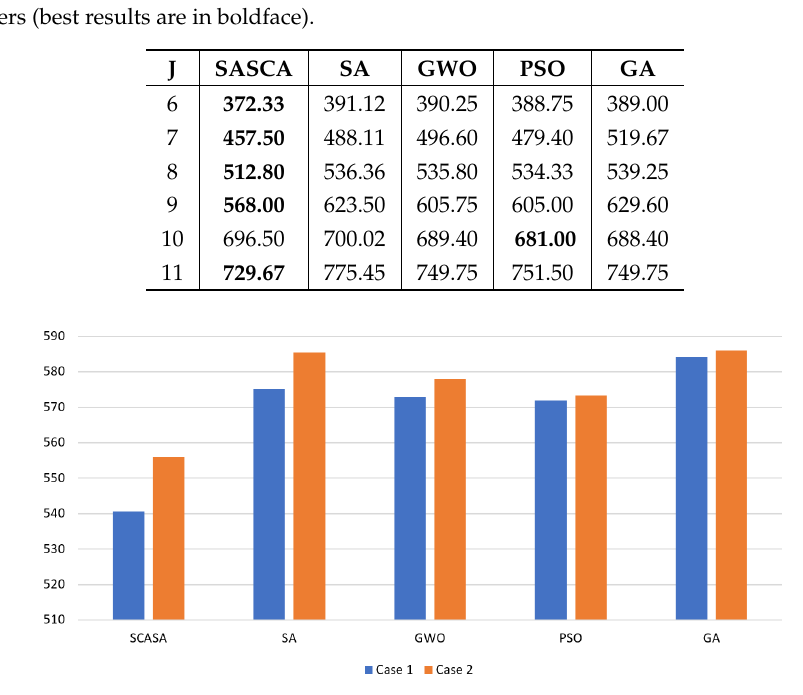
Figure 3. Average C max of the 6 jobs on 2 machines to show the difference between the original parameters (Case 1) and the new parameters (Case 2) to show the performances of all